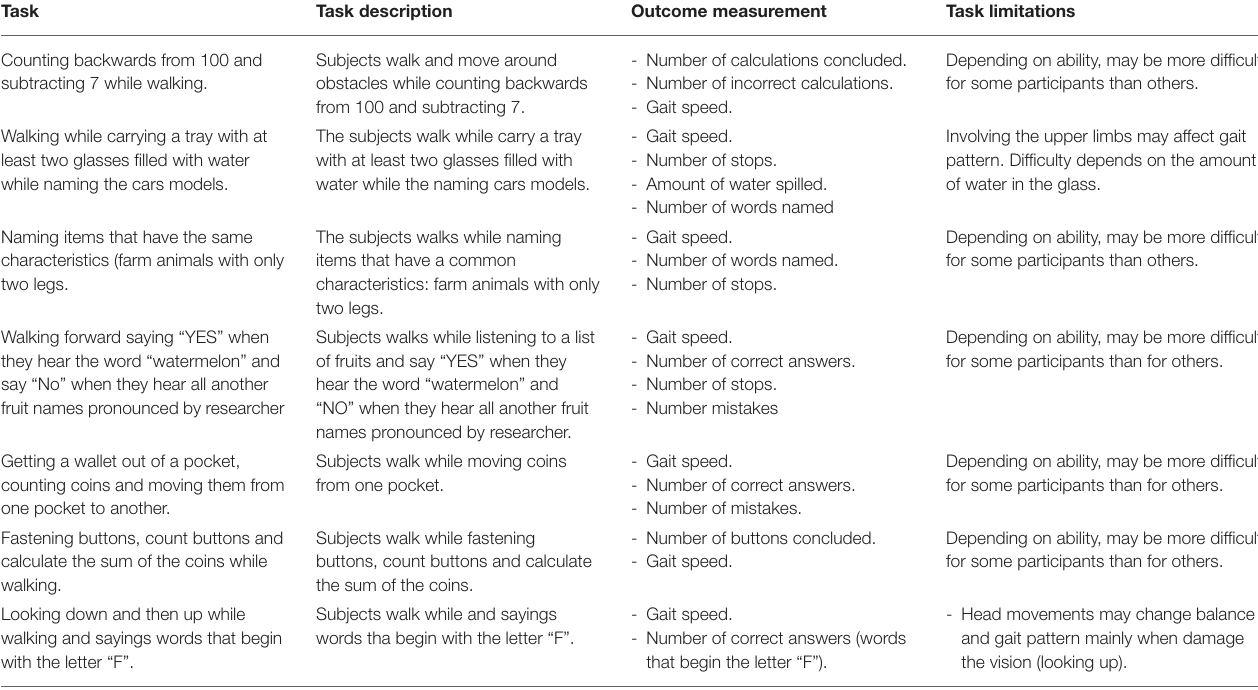
TABLE 4 | Dual-task training at difficulty level 3. Task Task description Outcome measurement Task